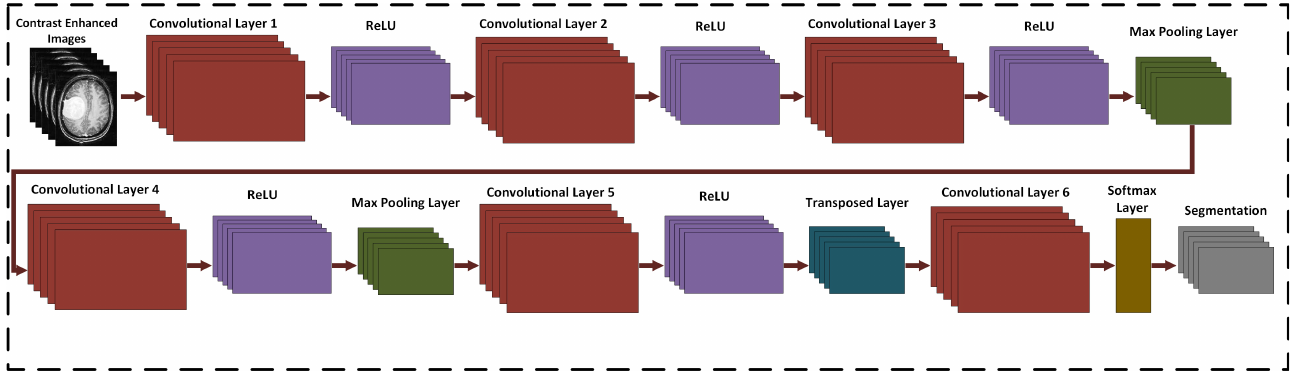
Figure 5. Proposed custom 17-layered CNN architecture for brain tumor